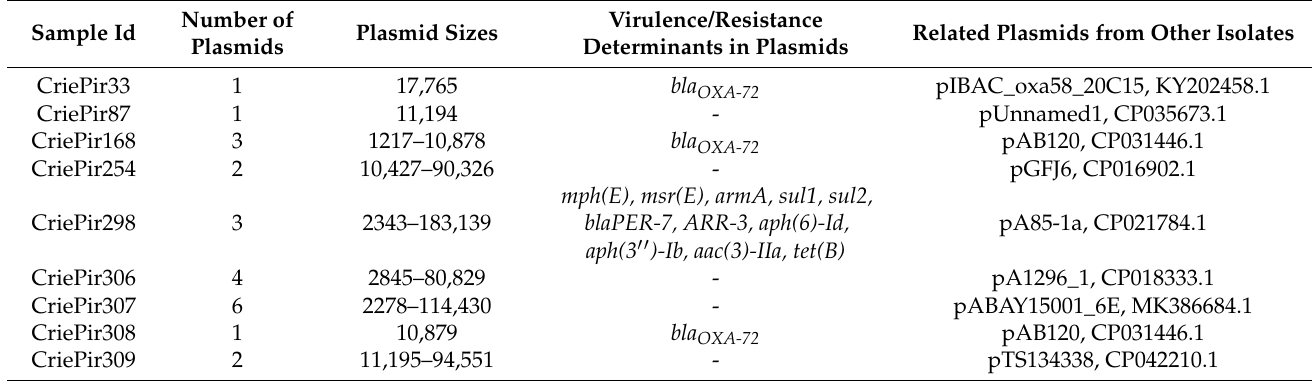
Table 2. Plasmid characteristics of the isolates